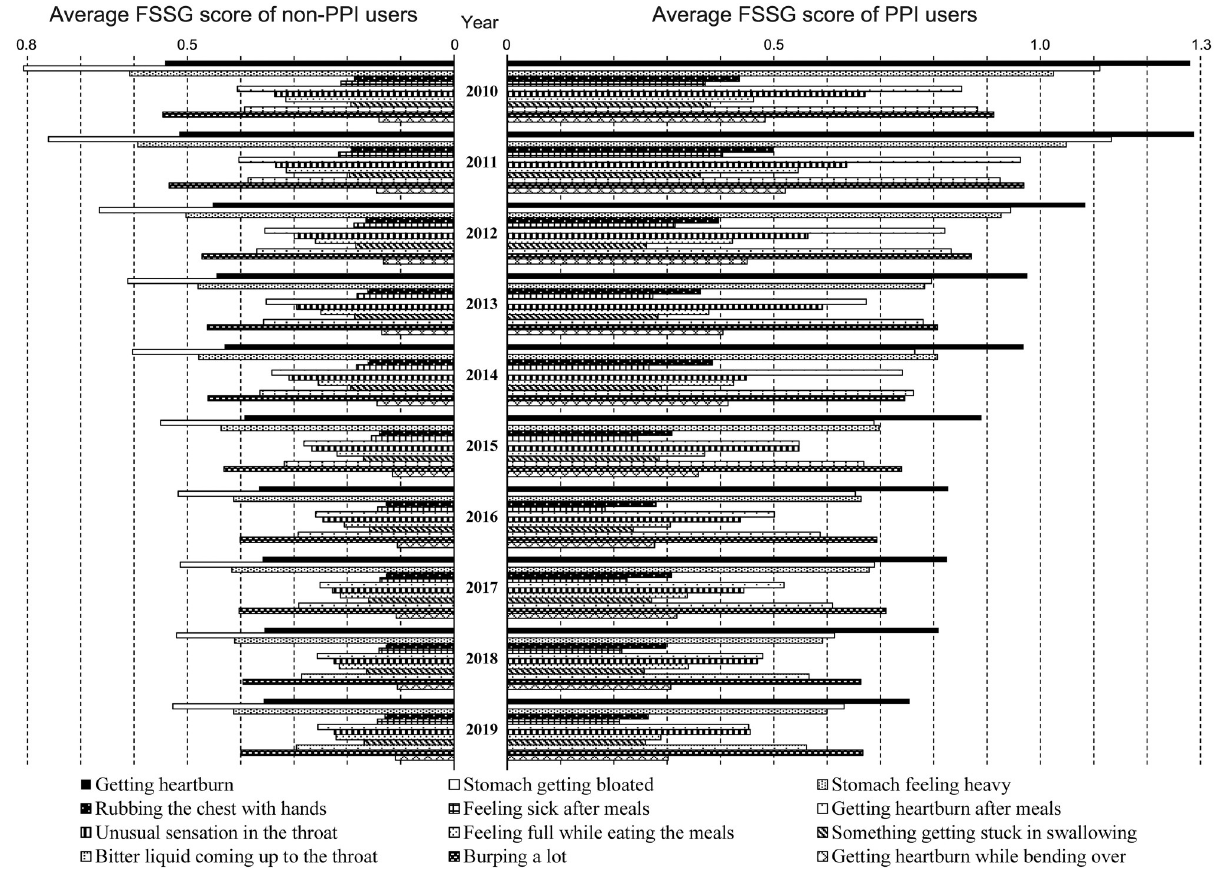
Fig 4. Changes in the 12 gastrointestinal symptoms based on the FSSG scores from 2010 to 2019 among generally healthy individuals in Japan. The left half shows the average score of 12 FSSG symptoms in non-PPI users, and the right half shows the average score of 12 FSSG symptoms in PPI users. FSSG, frequency scale for the symptoms of gastroesophageal reflux